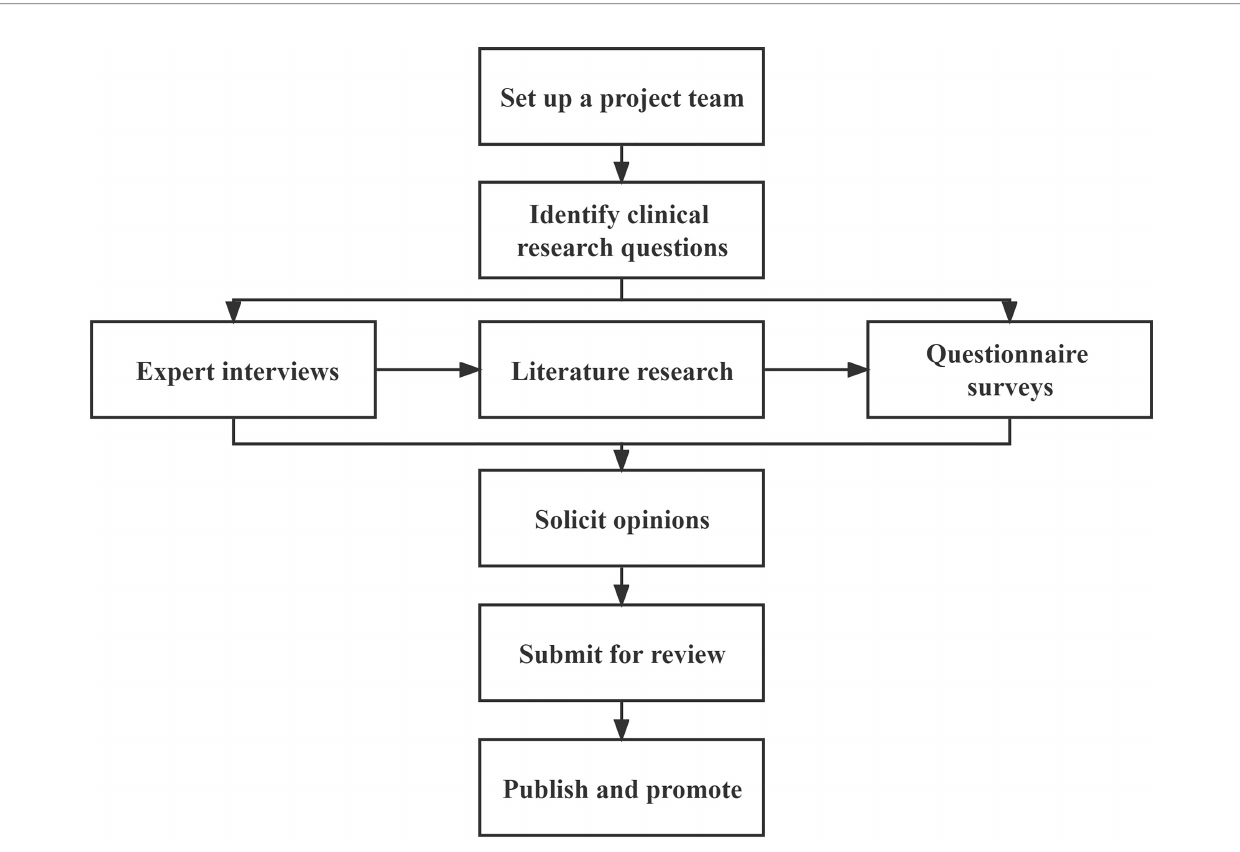
FIGURE 1 | Flowchart for the development of Standards for collection, preservation, and transportation of fecal samples in TCM clinical